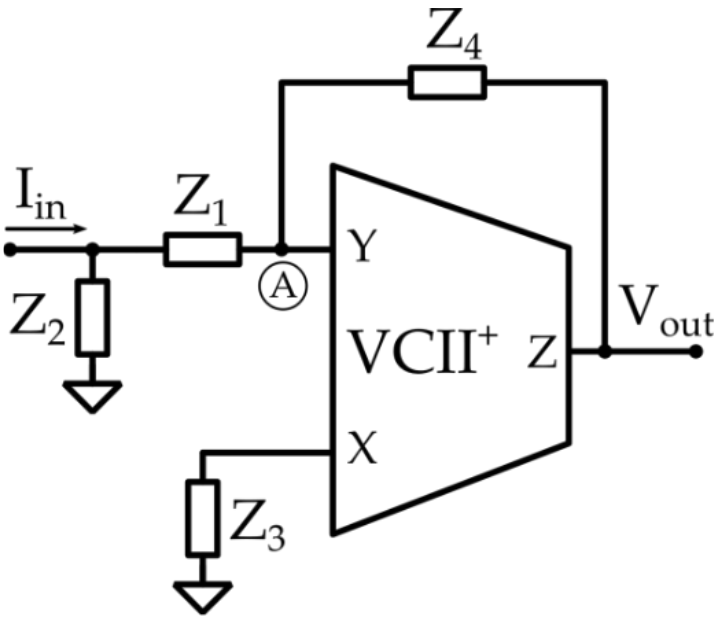
Figure 15. VCII-based second-order low-pass and bandpass filter.